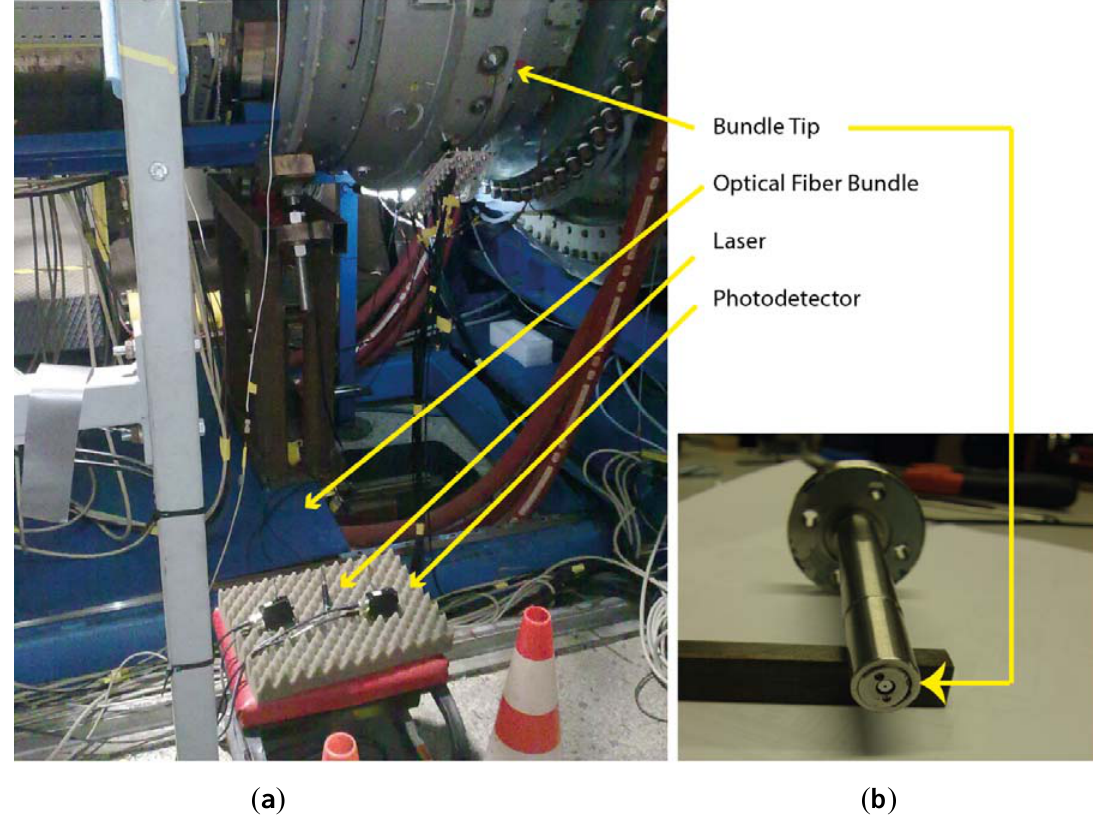
Figure 3. ( a ) Experimental setup for the tip clearance and tip timing measurements in the